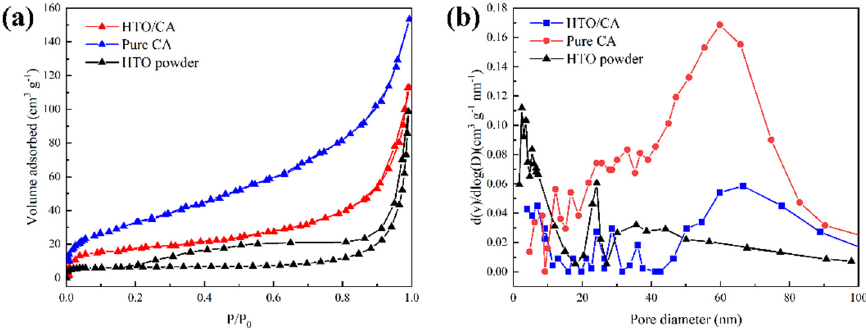
Figure 3. ( a ) N 2 adsorption/desorption isotherms of the pure CA, HTO powder, and HTO/CA; ( b ) pore size distribution curves of the pure CA, HTO powder, and